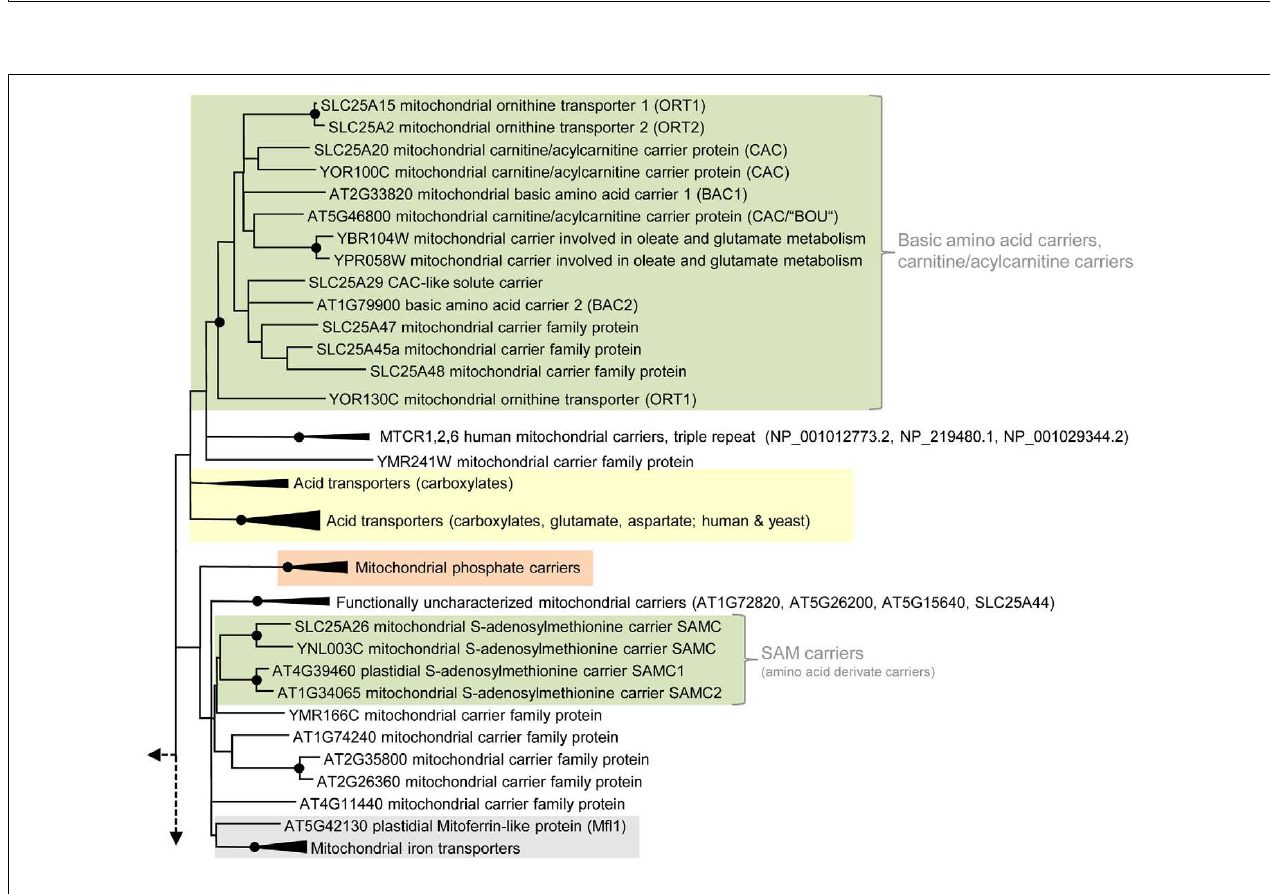
shown in Figure 3 are displayed (green shaded subsets). Nodes that are supported by bootstrap values (maximum likelihood and maximum parsimony, 1000 replications) higher than 70 are indicated by black